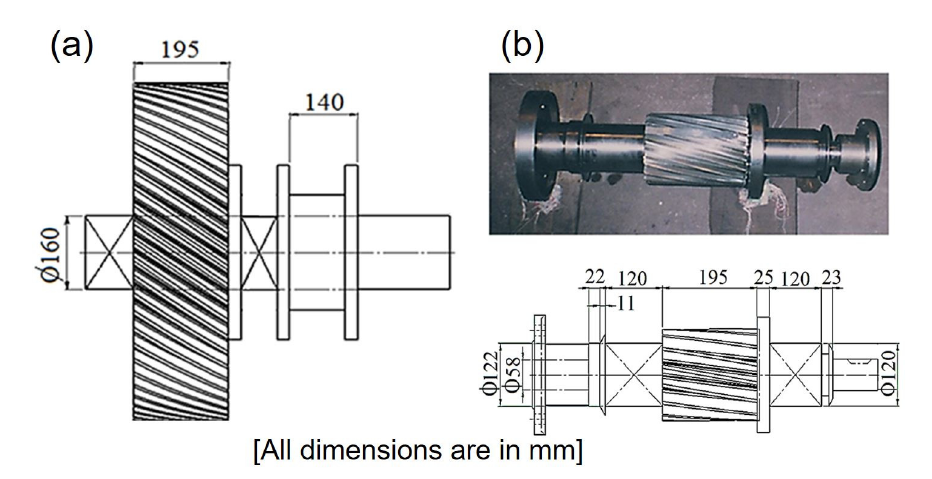
Figure 2. ( a ) Key dimensions of pinion and gear in schematic view; ( b ) photographic view of